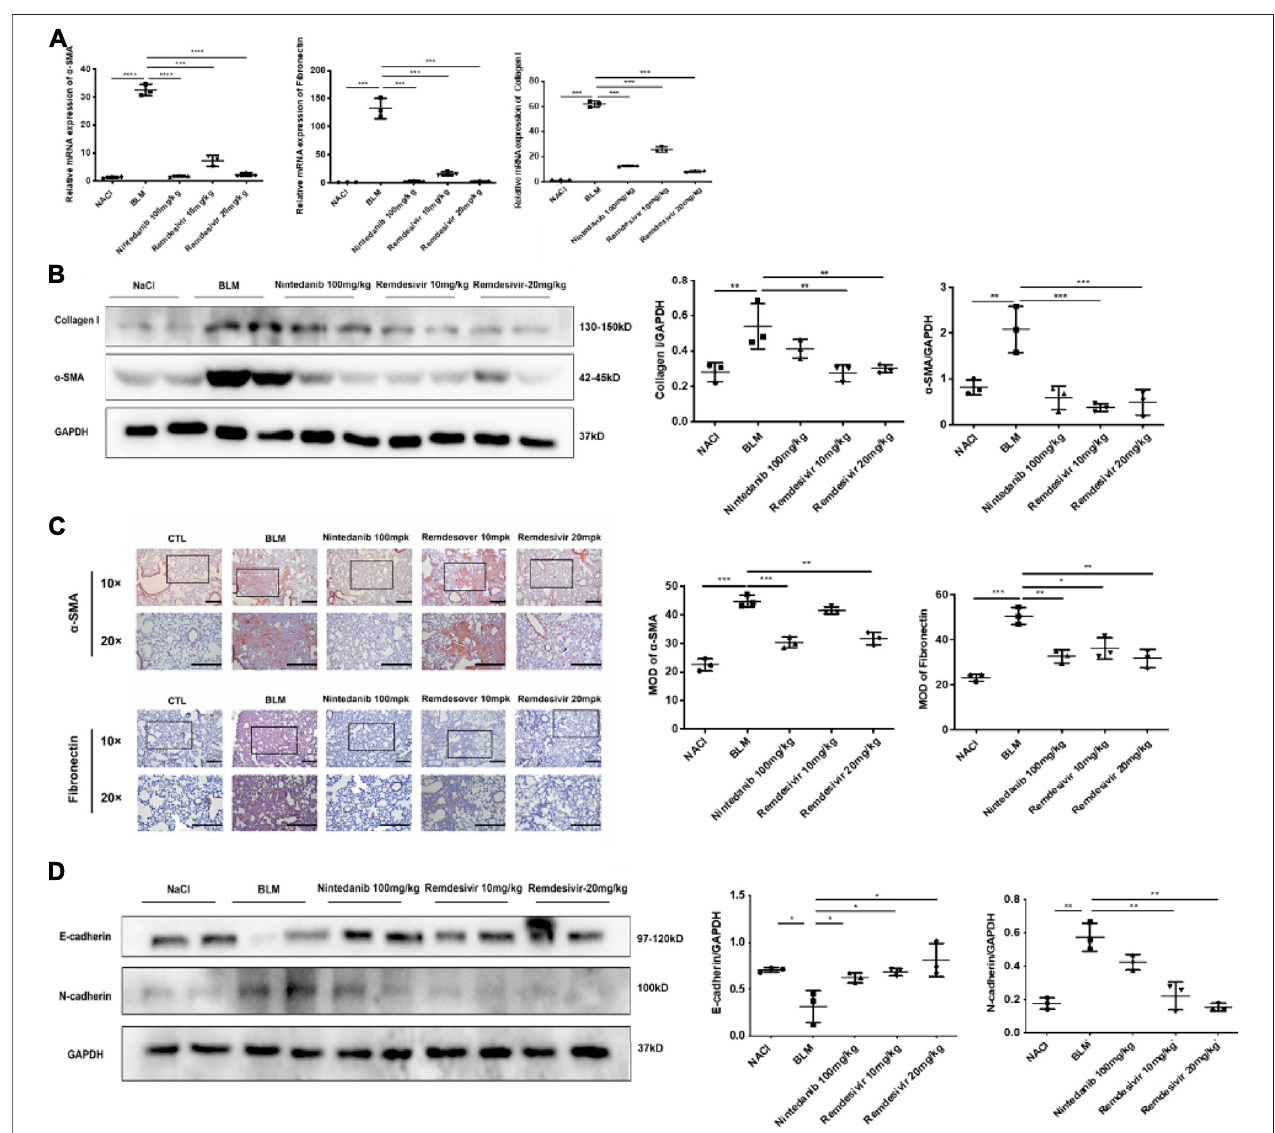
FIGURE 9 | Remdesivir attenuates BLM-induced fi broblast activation and epithelial injury in vivo (A) RT-PCR was performed to detect mRNA levels of α -SMA, Fibronectin and Collagen I in lung tissues. (B) Protein levels of α -SMA and Collagen I were veri fi ed by Western blot in lung tissues. GAPDH was used as an internal reference in densitometric analysis (C) Immunohistochemical staining analysis of α -SMA and Fibronectin in lung tissues. (D) Protein expression levels of E-cadherin and N-cadherin wereassessed byWestern blotinlung tissues.GAPDHwasused asaloadingcontrol. Datawaspresentedasthemeans ± SD, n (cid:1) 3. * p < 0.05,** p < 0.01, *** p <